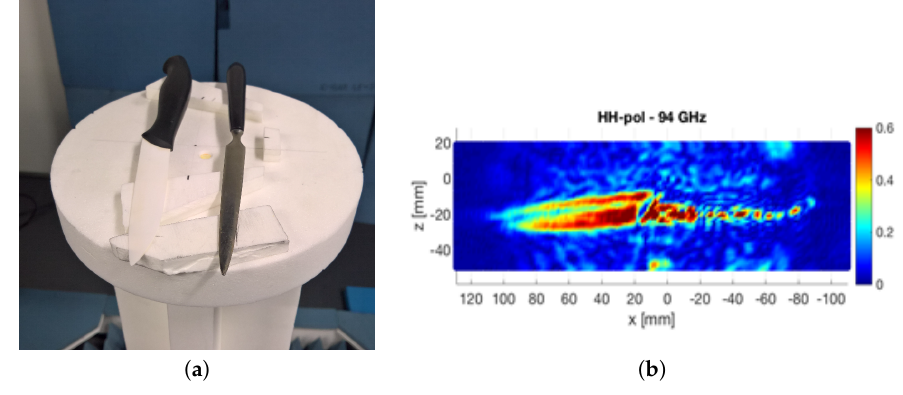
Figure 4. ( a ) Knives; ( b ) radar acquisition.